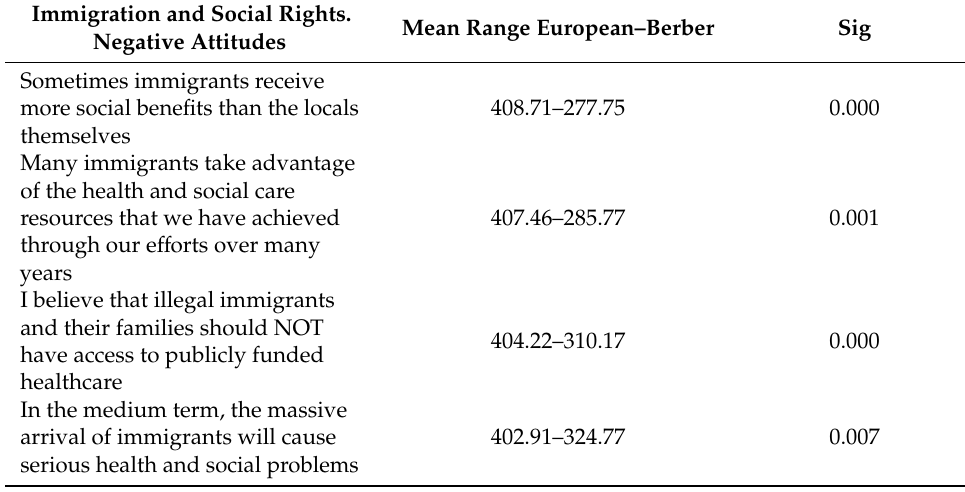
Table 3. Immigration and Social Rights. Negative attitudes with statistically significant di ff erences according to the variable: cultural background.